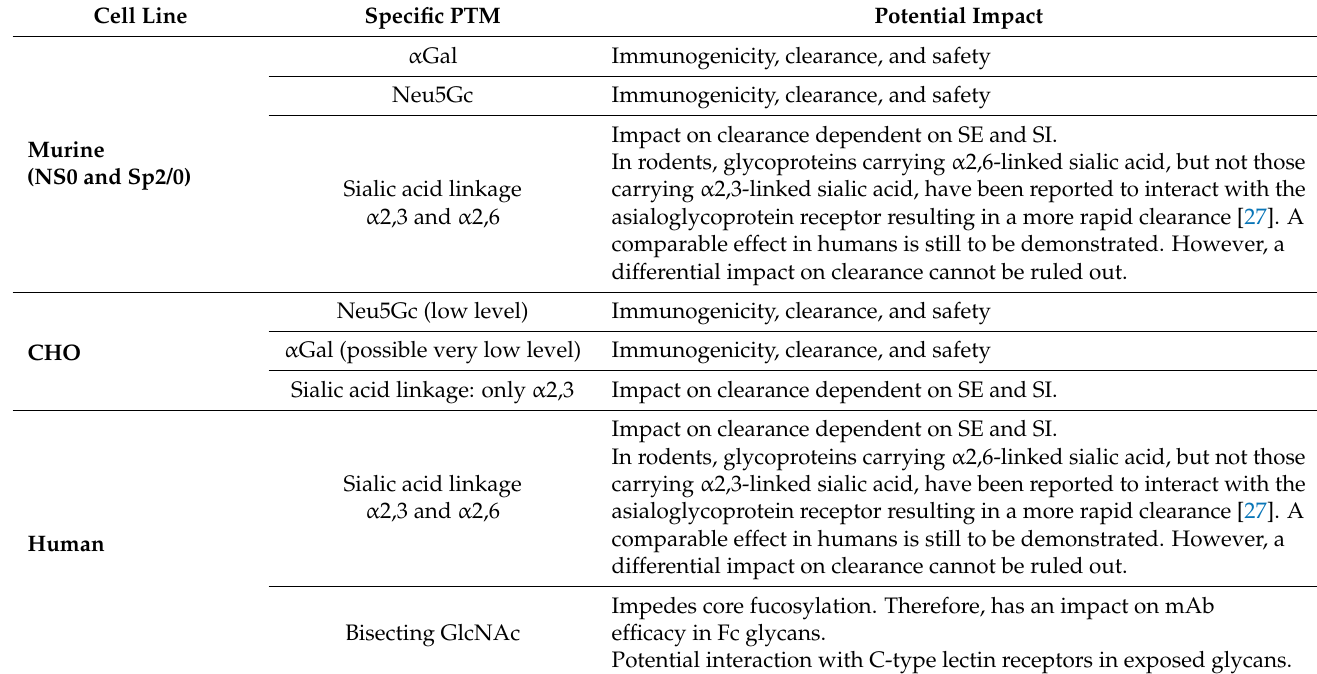
Table 2. Cell-line-specific glycan-related